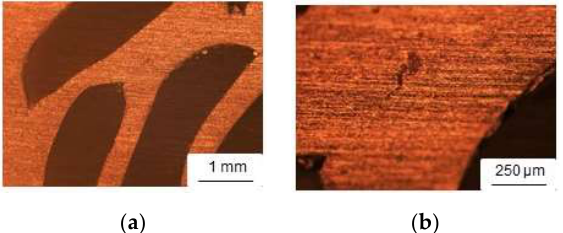
Figure 8. Metallographic images of the transversal cross-section of UniPore specimen. ( a ) lower magnification; ( b ) higher magnification.